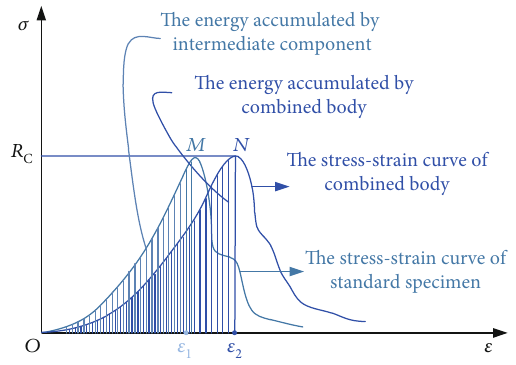
Figure 3: Energy distribution analysis of the combined